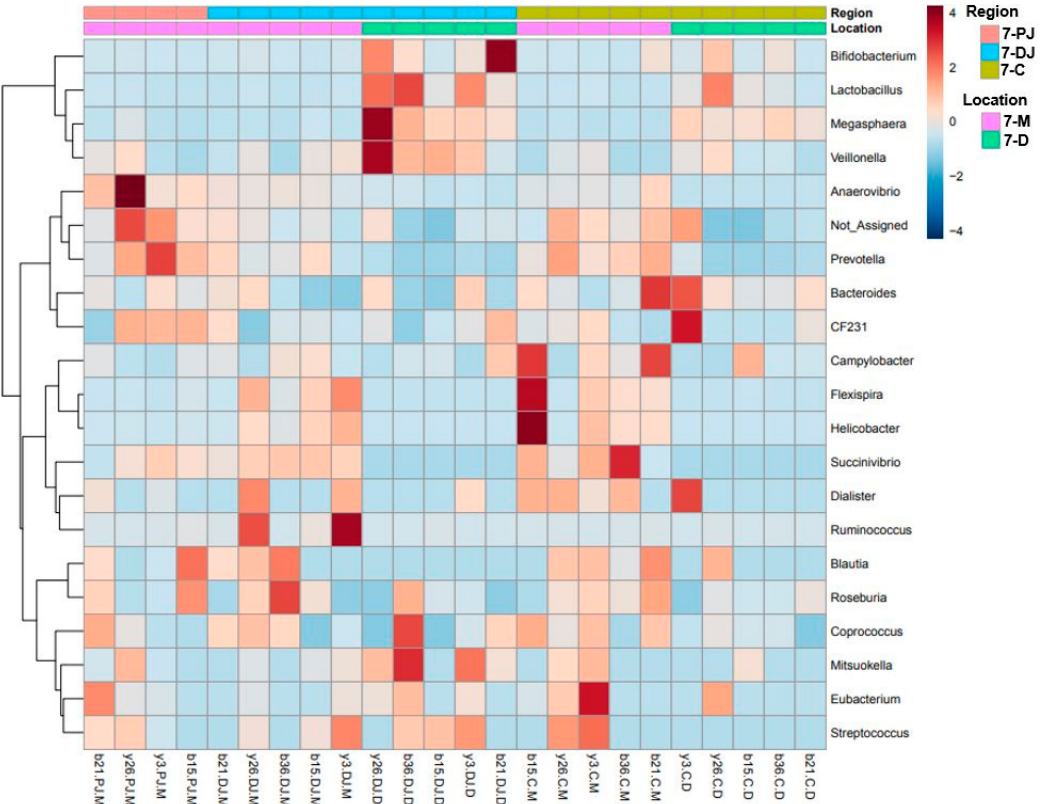
Figure 3. Hierarchical clustering heat map of bacterial genera from 7-day post-weaned pigs generated by MicrobiomeAnalyst using Euclidean distance measure and Ward clustering algorithm. The 7 represents 7 days post weaning; M and D represent mucosa and digesta samples, respectively; PJ, DJ, and C represent proximate jejunum, distal jejunum, and mid-colon, respectively. Not_Assigned represents the sequence reads that were not assigned at the genus level but assigned at the higher taxonomic level.